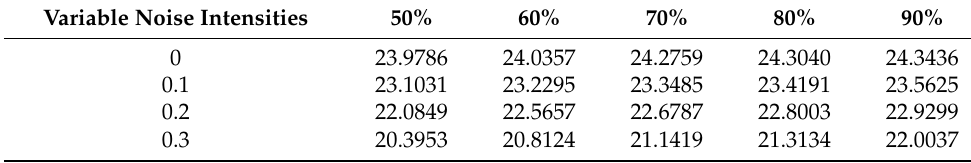
Table 5. The PSNR (dB) of the IASR-CNN method with different usage ratios. Variable Noise